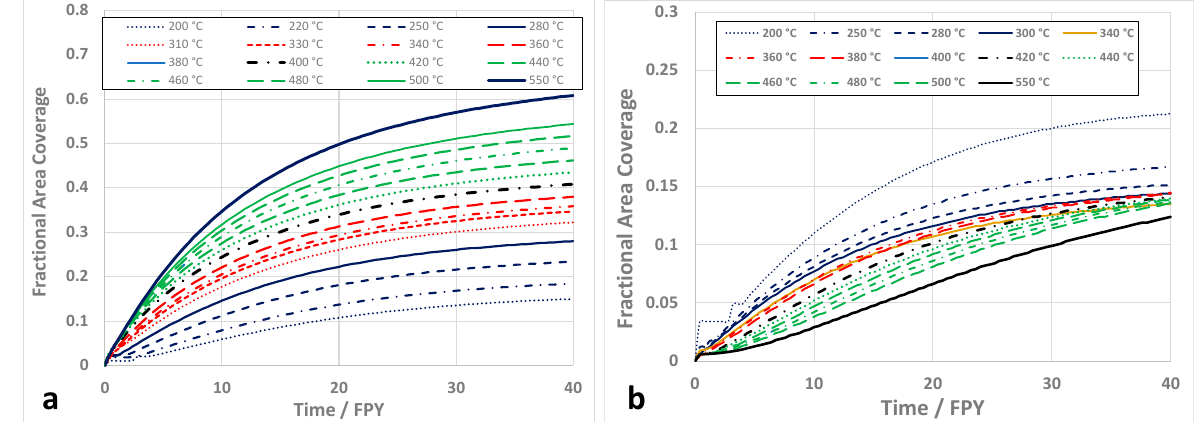
Figure 15. Hypothetical grain boundary cavity coverage as a function of dose (DPA) for Inconel X-750 material irradiated in the neutron flux of a CANDU reactor assuming: ( a ) a bubble evolution model; ( b ) a void evolution model. The surface energy (s) was assumed to be 1 J.m − 2 and the recombination parameter (r) was assumed to be 380.